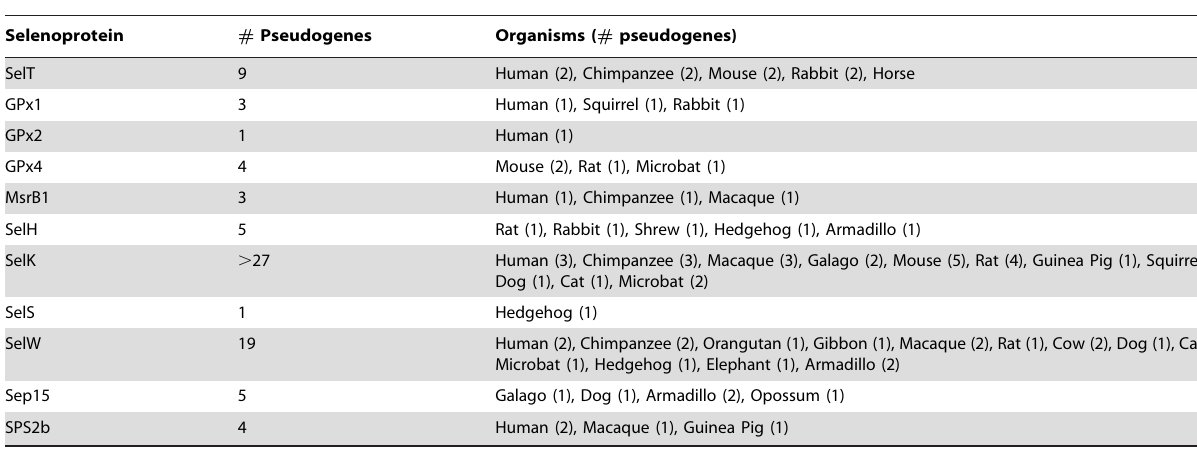
Table 2. Mammalian selenoprotein pseudogenes.